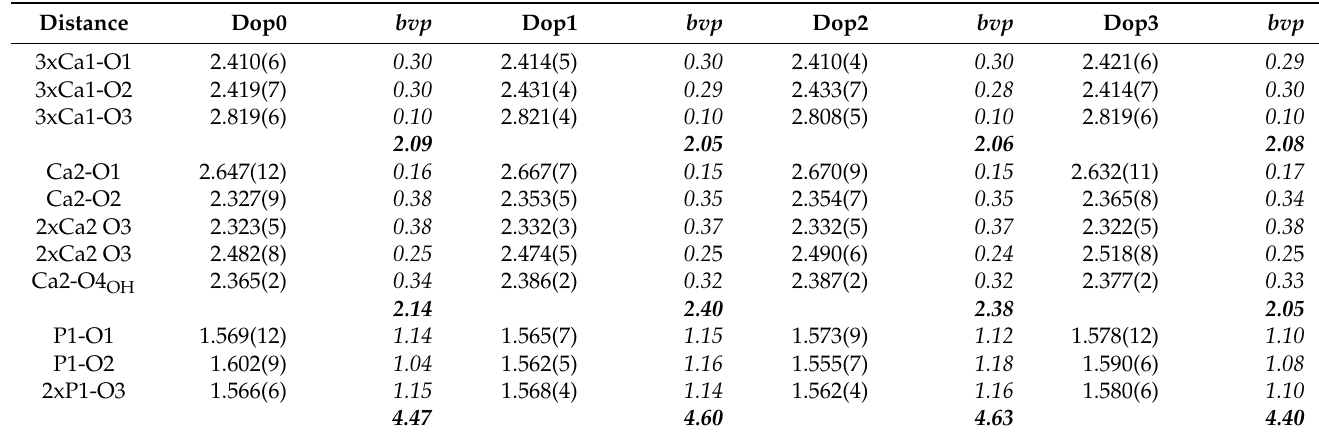
Table 4. Bond distances (Å) and bond valence parameters (valence units) for pure and Sr-doped HAp samples.